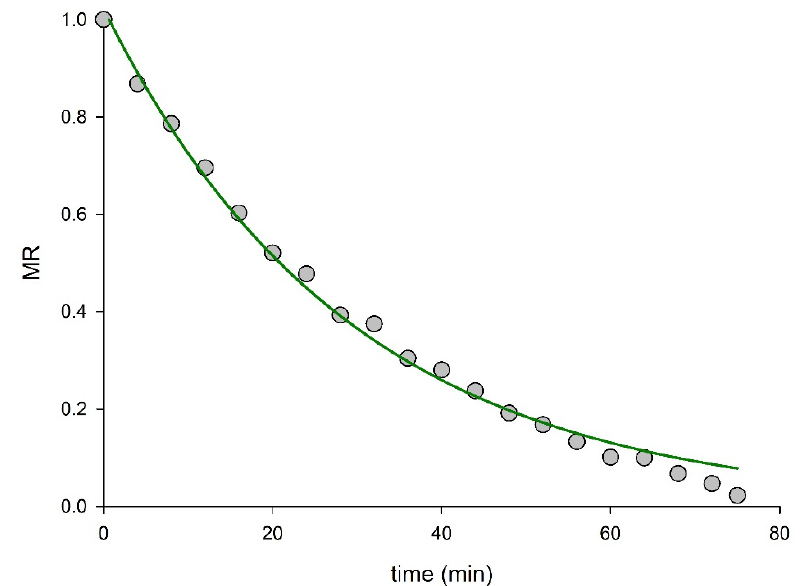
Figure 4. Drying data of peach slices at 60 °C (gray circles). Solid line indicates the fit of modified Henderson–Pabis model [Equation (6)], where R 2 = 0.9931 and RMSE = 0.0285. Original data are from Zhu and Shen [19]. Table 2. Parameter estimates, standard errors and p values of the modified Henderson and Pabis equation [Equation (6)] to the data shown in Figure